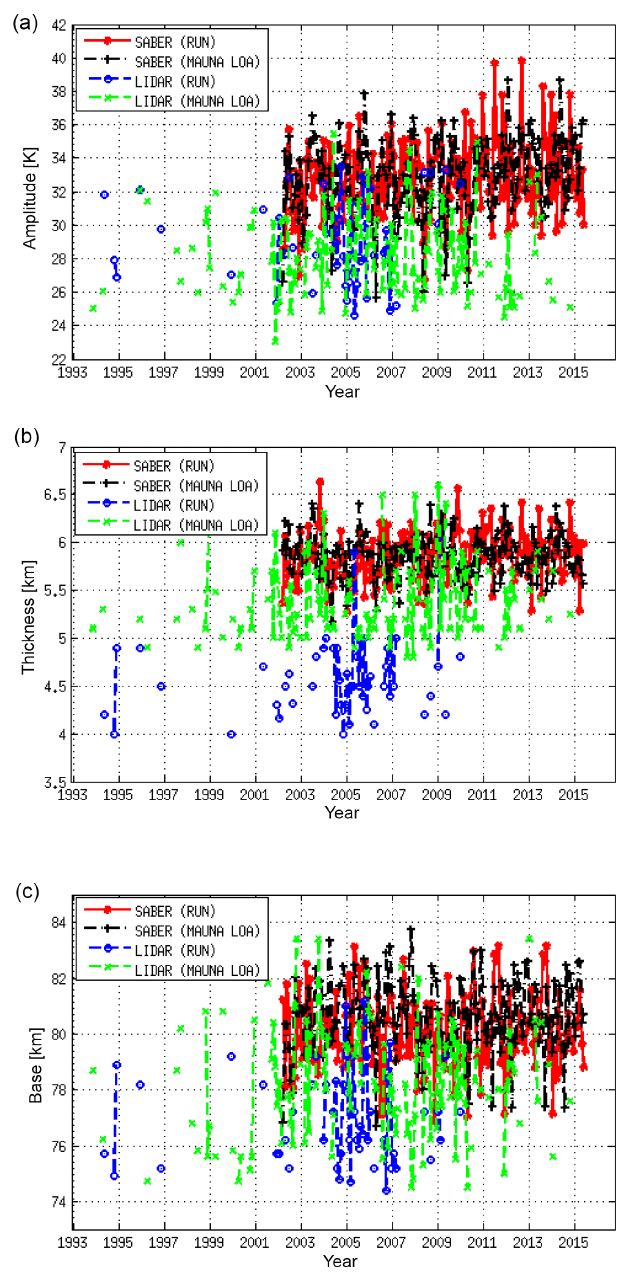
Figure 5. Time evolution of monthly (a) amplitude, (b) thickness and (c) base of the inversion layer obtained from lidar and SABER observations over Réunion and Mauna Loa, respectively, for the pe- riod